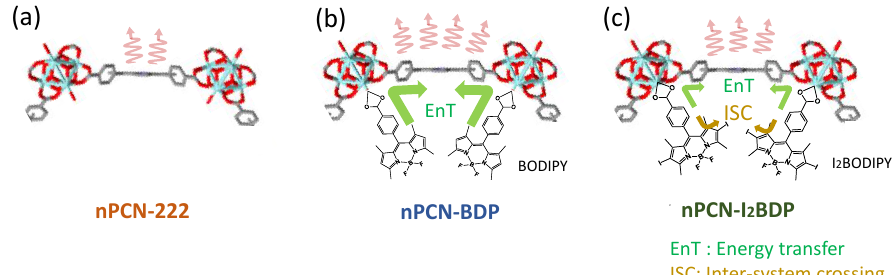
Figure 3. Expectation of transition pathways of the incorporated MOFs system. ( a ) Fluorescence emission of nPCN-222. ( b ) Enhanced fluorescence emission of nPCN-222 (acceptor) induced by resonance energy transfer from BODIPY (donor) in nPCN-BDP. ( c ) Energy transfer and inter-system crossing can occur in nPCN-I 2 BDP.